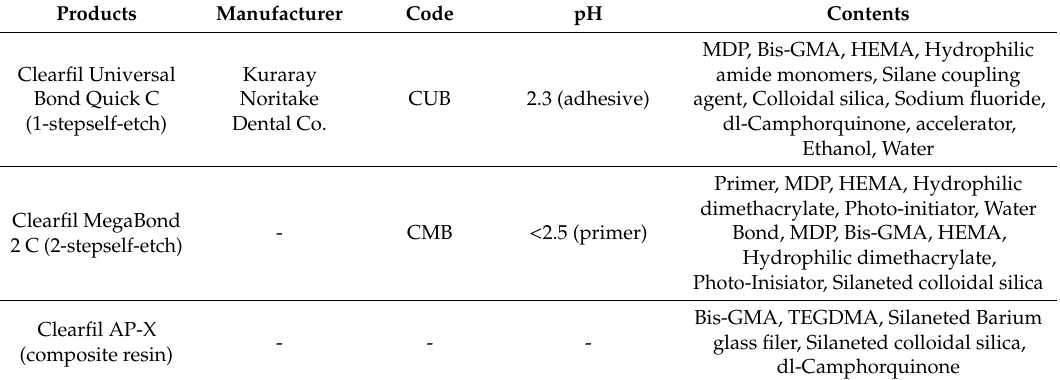
Table 1. Materials used in this